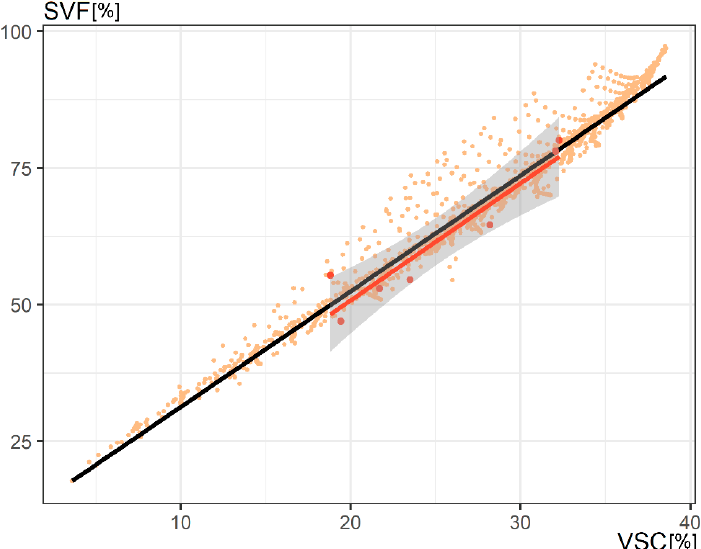
Figure 15. Linear regression function of metrics VSC and SVF based on neighbourhood iterations (black line) and case studies (red line), including the 95% CI for the case studies regression line indicated by the grey area.